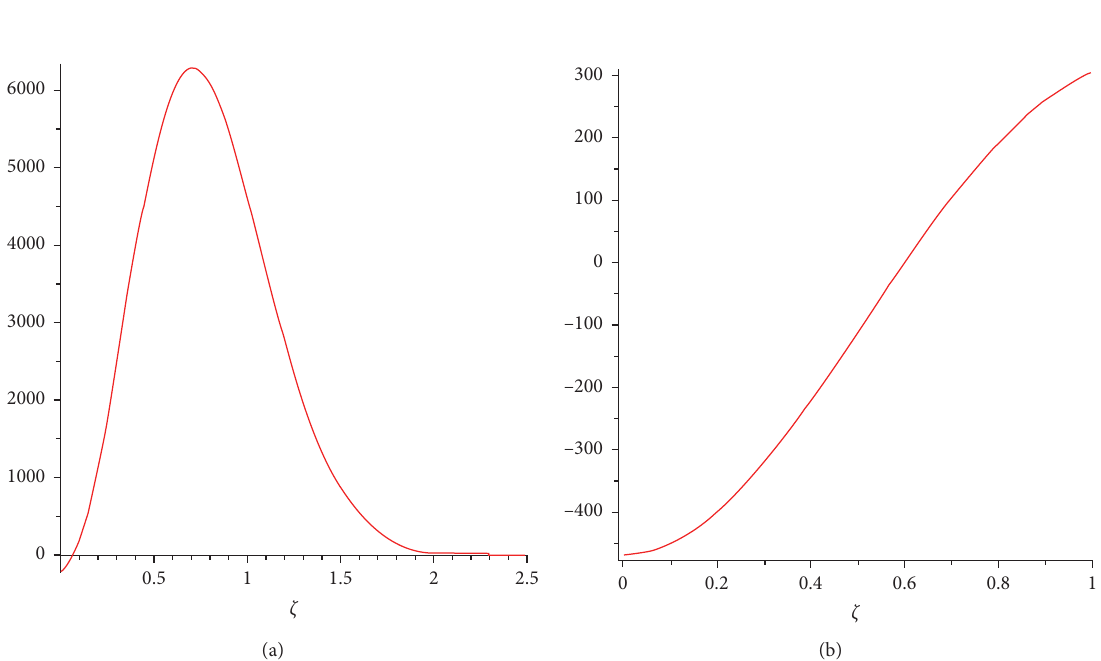
Figure 6: HPTM solutions of μ ( ζ , Ψ ) and ρ ( ζ , Ψ ) at c �